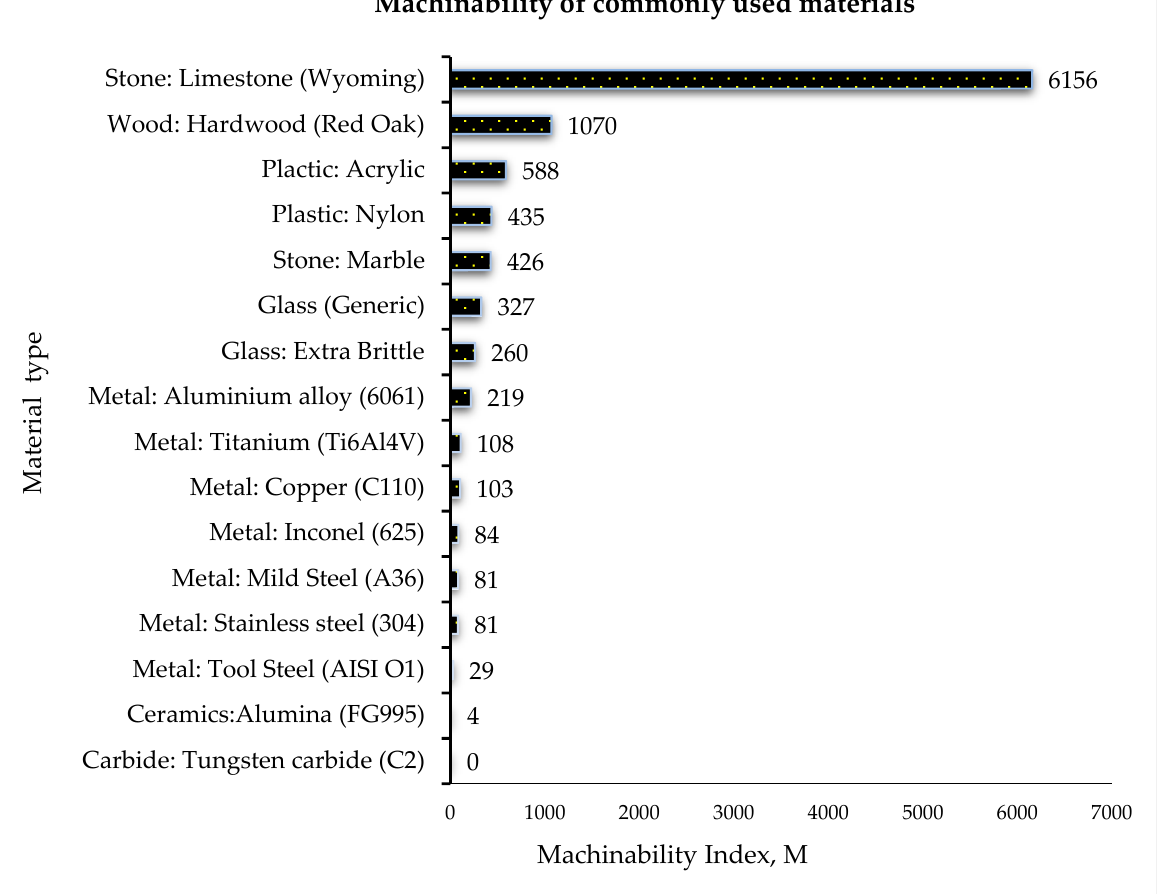
Figure 3. Machinability of frequently employed materials in AWJ cutting applications [69].